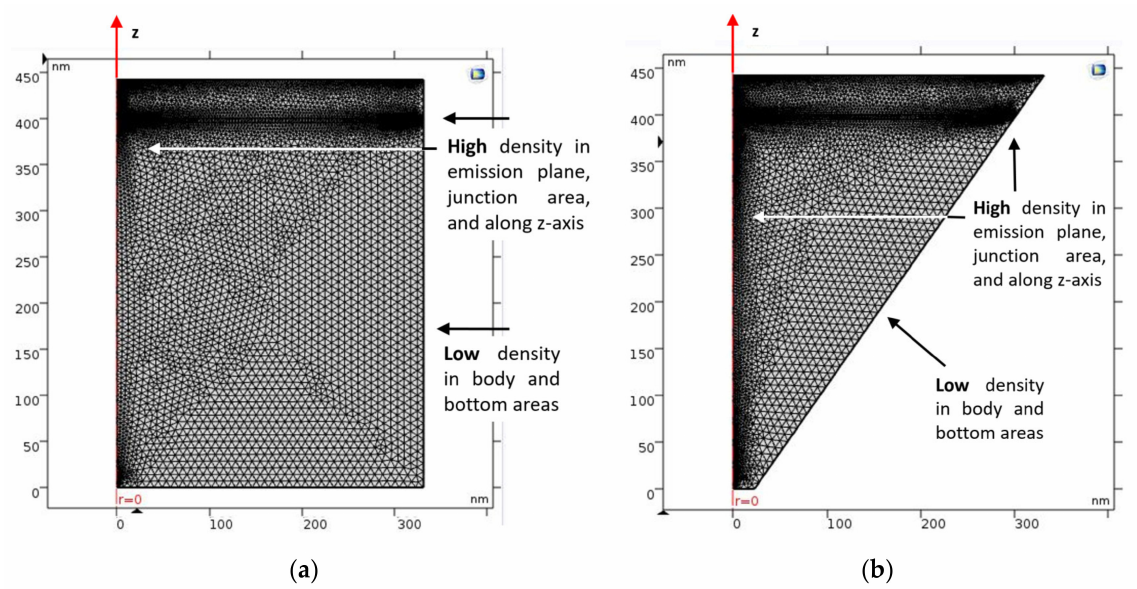
Figure 3. 2D representation of the device mesh density distribution, with an axial symmetry around the z-axis and using cylindrical co-ordinates. ( a ) Cylindrical shape (regular device); ( b ) conical shape (LENS